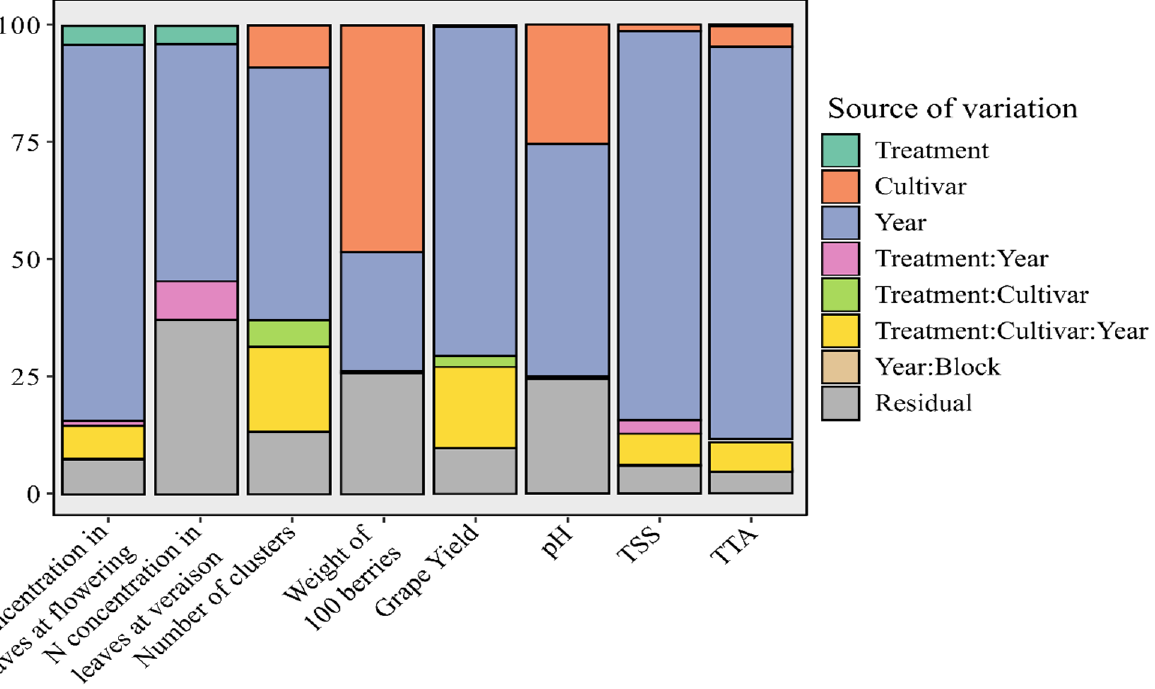
Figure 2. Visual representation of variance components. The colors represent the source of variation (treatment, cultivar, year, interactions, and residual). Response variables (plant tissue, grape yield, and composition) are shown on the X -axis. The variation proportion explained by each source of variation for each response variable is observed on the Y -axis (percentage).